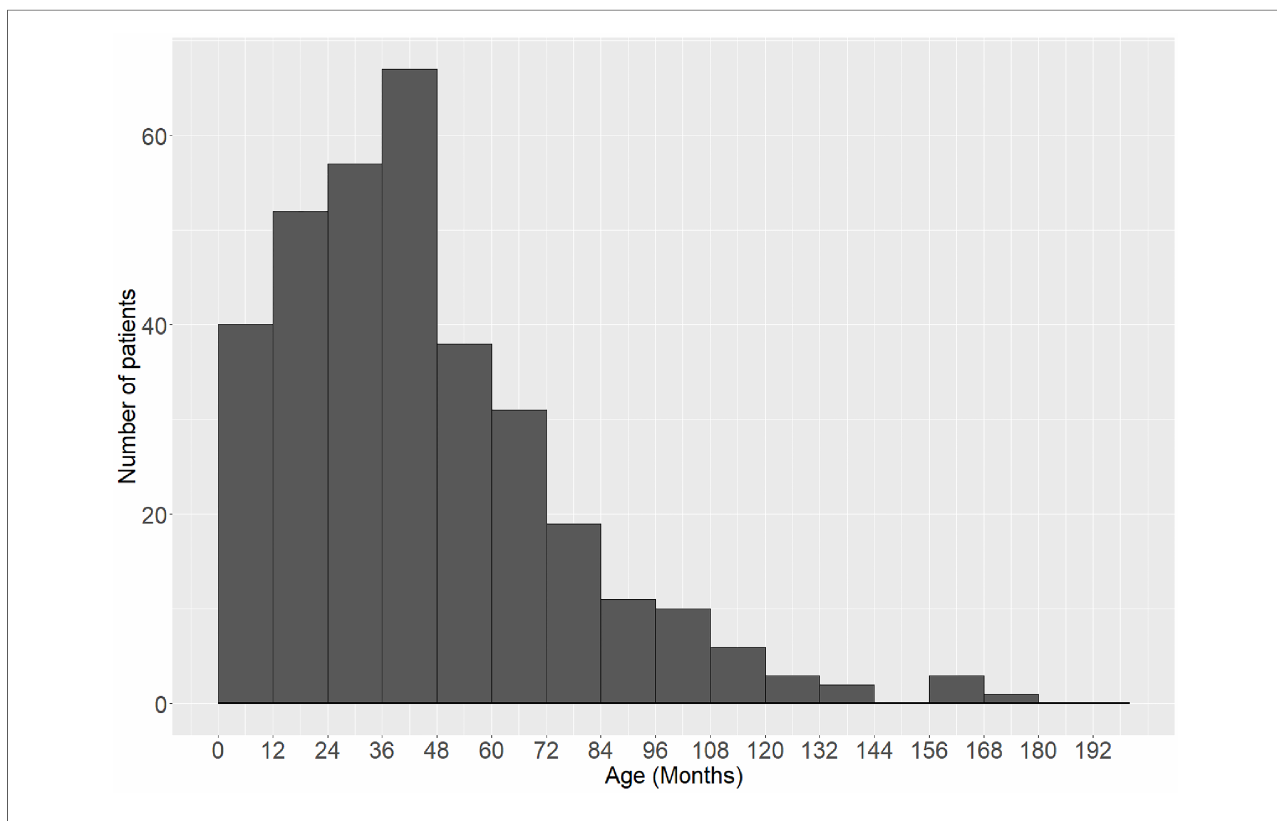
FIGURE 2 Distribution of included patients ’ age at operation.